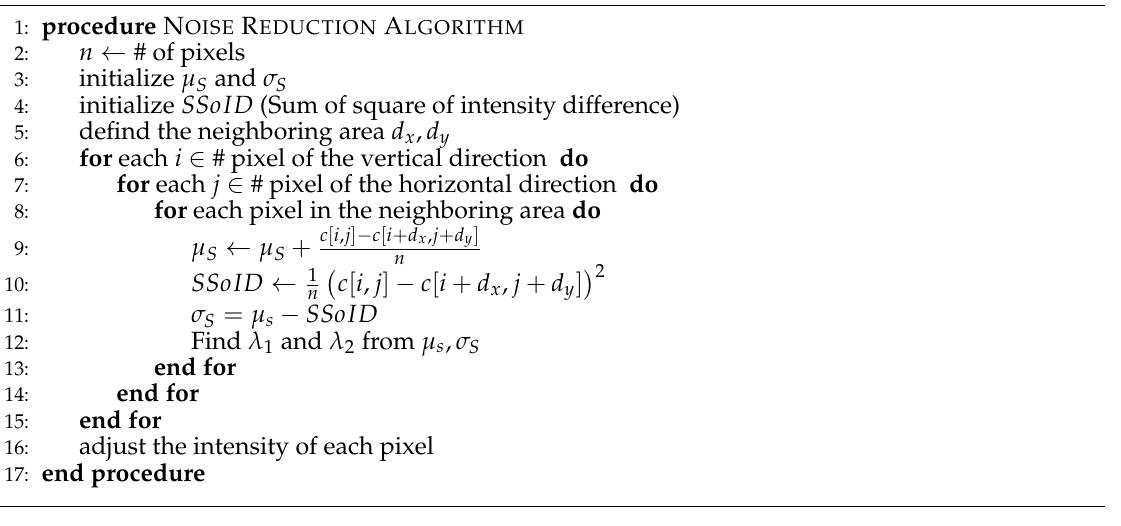
Algorithm 1 Noise reduction algorithm